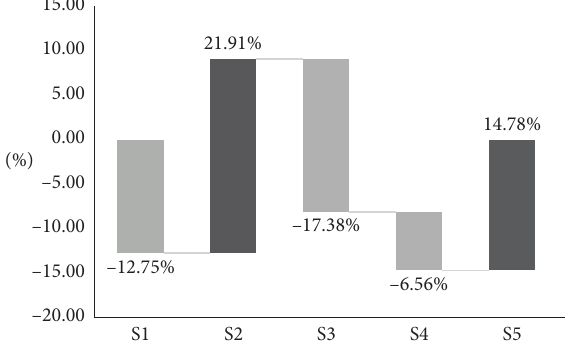
Figure 9: Inventory change range of the temporary storage site.